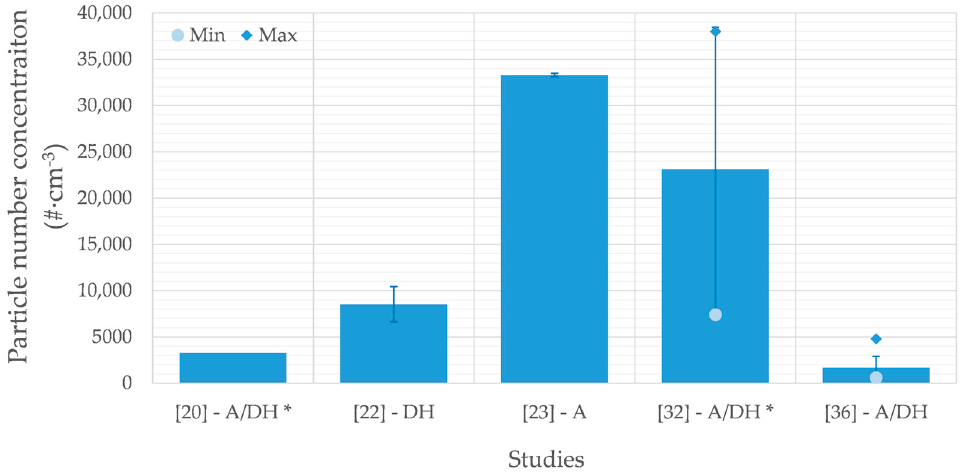
Figure 9. Ultrafine particles levels monitored during the sleep period in naturally ventilated bedrooms in different types of building: A—apartment; A/DH—mixed (apartment and detached house); DH—detached house. Bars provide mean values (along with standard deviation when available). * These studies do not specify the type of bedroom ventilation.